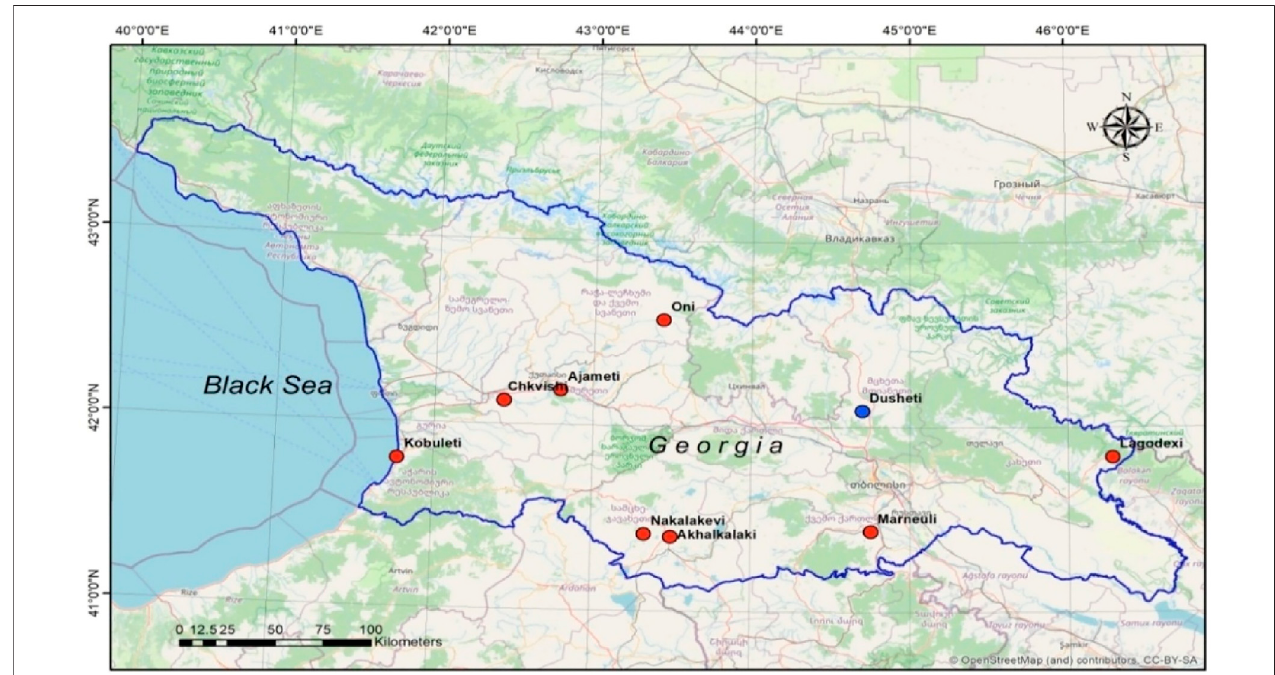
FIGURE 1 | Map of Georgia with the location of deep wells ’ network (red circles) for water-level monitoring and Dusheti Geomagnetic Observatory (blue circle).